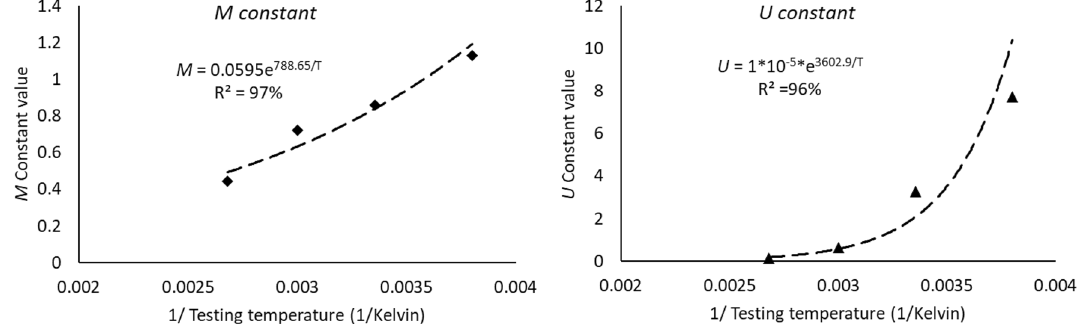
Figure 17. The prediction models for the coffin Manson parameters using the Arrhenious